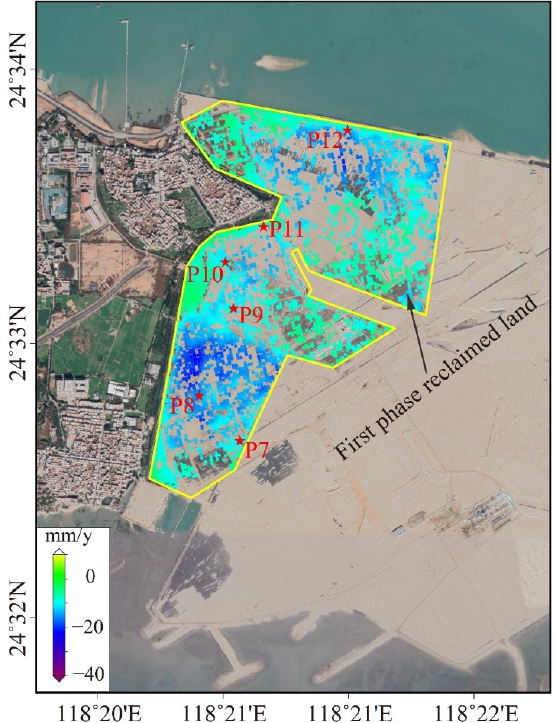
Figure A2. Locations of points P7–P12.